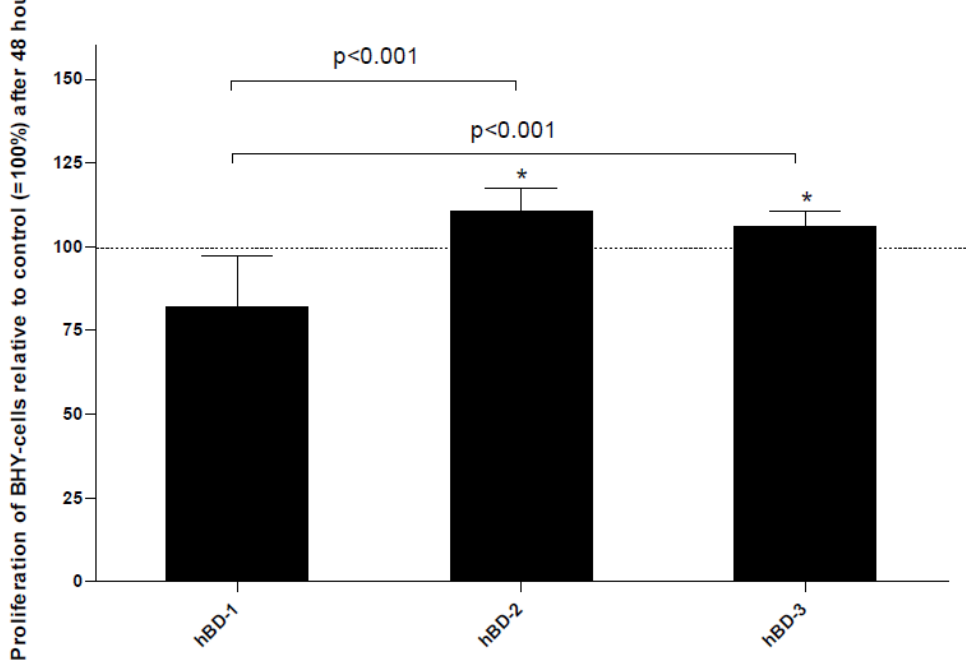
Figure 4. Significant changes in BHY cell proliferation after stimulation with 50 nM of hBD-1, -2 and -3 after 48 h are shown. Mean values of n = 12 experiments + standard deviation (SD) are depicted. Differences compared to the control are marked with * (p <